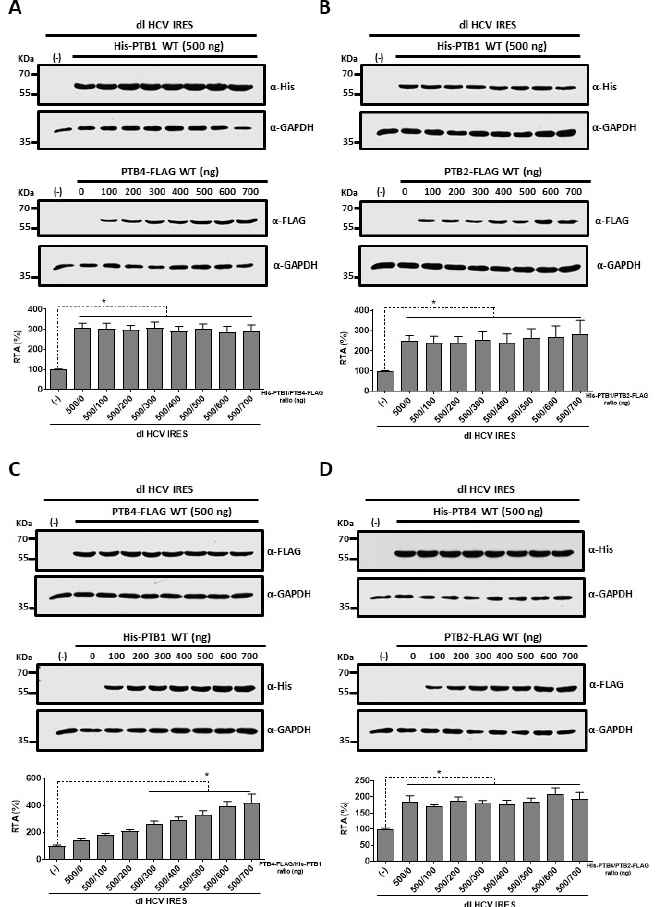
Figure 4. PTB1 ‐ induced stimulation of the HCV IRES activity is not altered by PTB4 or PTB2, but PTB1 complements PTB2. HuH ‐ 7 cells were cotransfected with the dl HCV IRES plasmid (100 ng), pcDNA3.1 LacZ DNA (25 ng), and PTB1 (500 ng) ( A , B ) or PTB4 (500 ng) ( C , D ) expressing plasmid, in combination with the indicated amounts of the plasmid expressing PTB4 ( A ), PTB2 ( B , D ), and PTB1 ( C ). The upper and middle panels show the detection of recombinant PTB isoforms and GAPDH by Western blotting. RLuc and FLuc activities were determined in the absence (pSP64 ‐ Poly(A)) or the presence of the indicated proteins, and data presented as RTA(%) are shown in the lower panel. The RTA value obtained in the absence of recombinant protein ( ‐ ) was set to 100% (±SEM). Values are the means (±SEM) from three independent experiments each conducted in du ‐ plicate. Statistical analysis was performed by the ANOVA test, followed by Dunnet multiple com ‐ parisons tests; * p < 0.05 vs. the 500/0 point in each graph.